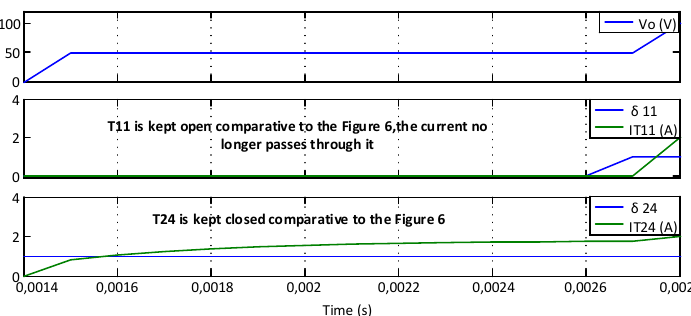
Figure 15. Voltage V o , currents IT11 and IT24, and switching patterns δ 11 and δ 24 (Zoom 1).